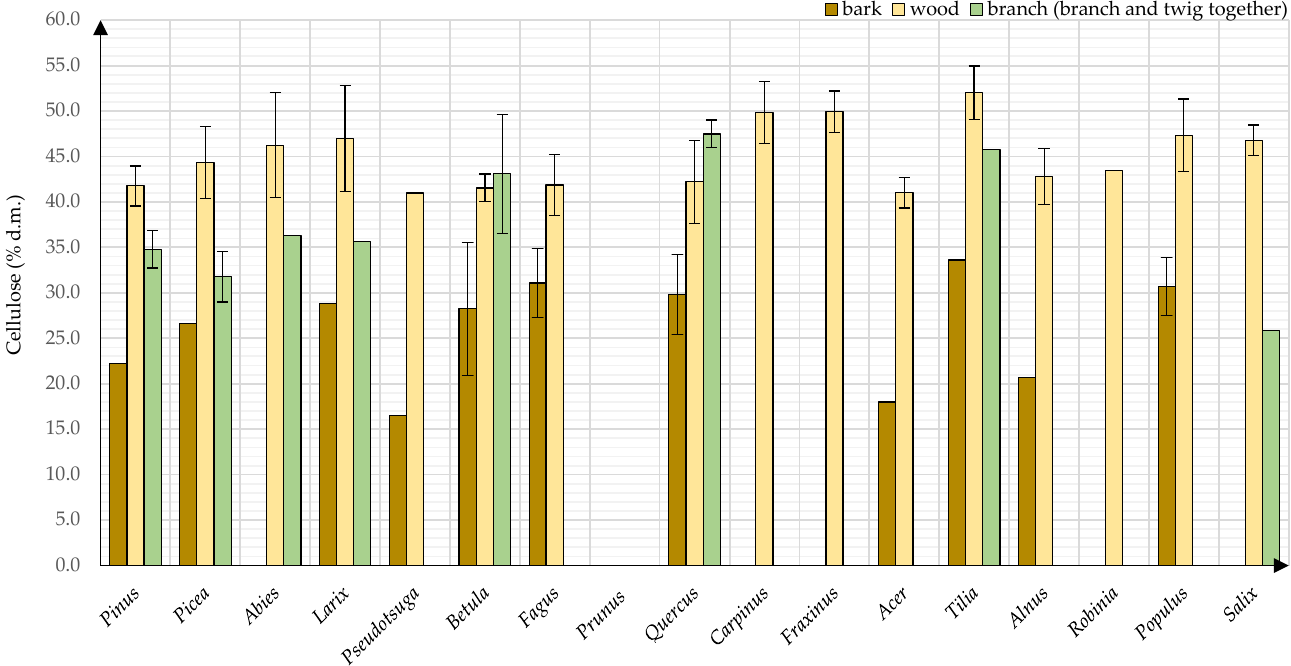
Figure 14. Average value and average deviation of the cellulose content of organs of particular systematic genera trees.